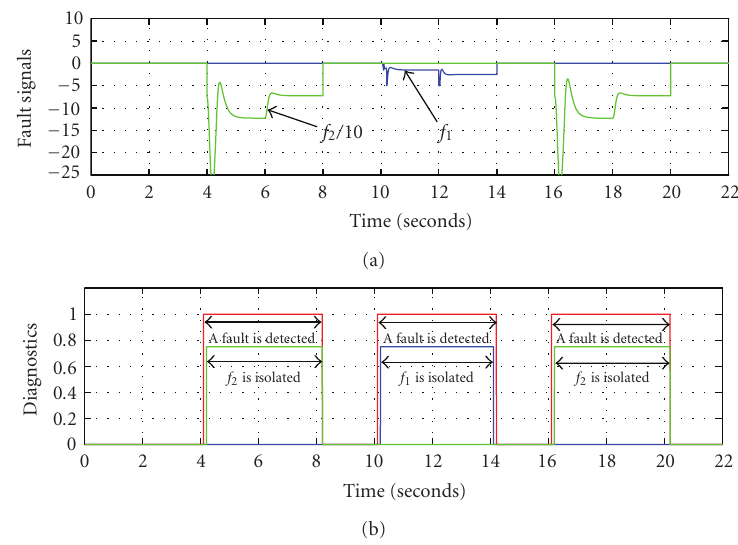
Figure 9: Simulation evaluation of FTC scheme: (a) fault signals, (b) detection and isolation